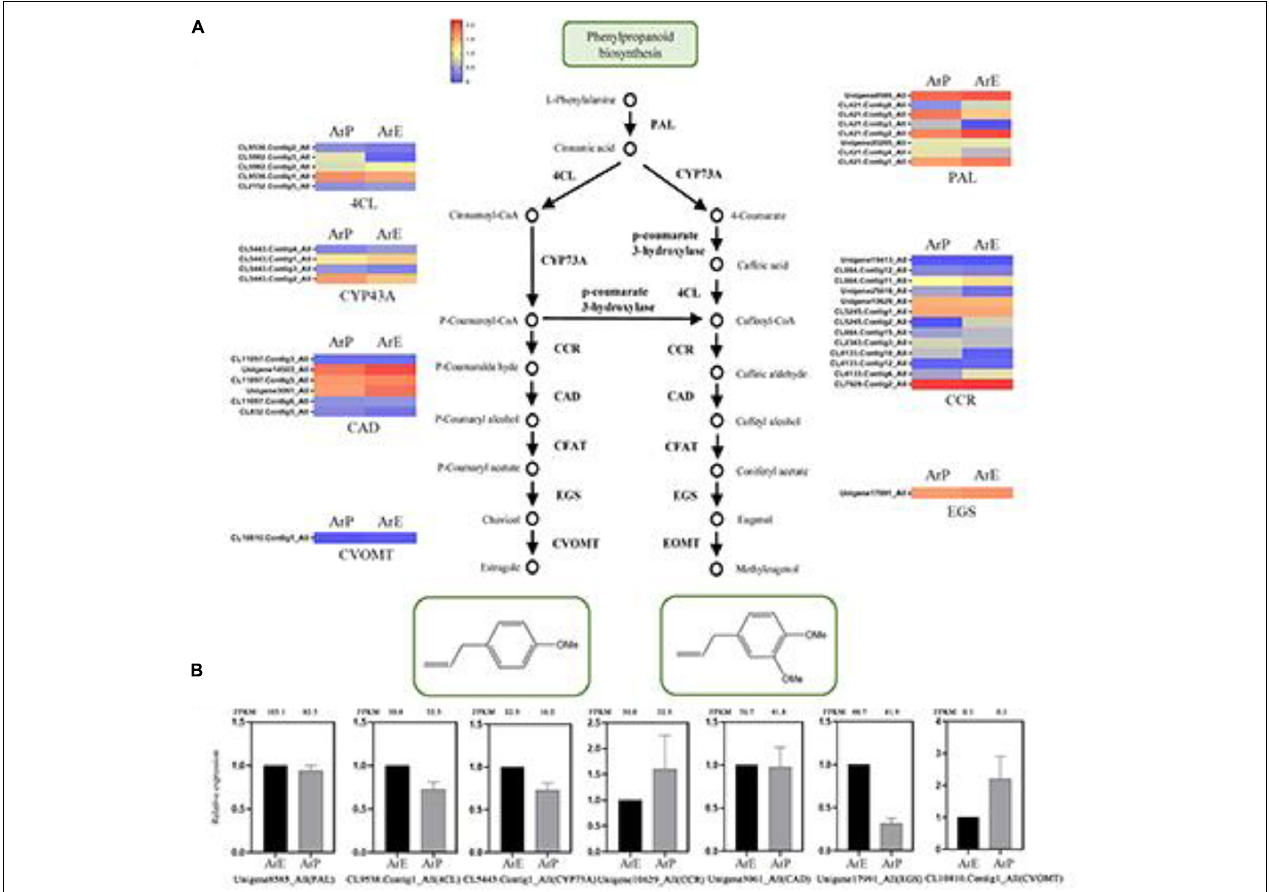
FIGURE 2 | Schematic overview of the phenylpropanoids biosynthesis pathway and the expression of representative genes by RT-qPCR. (A) Schematic overview of the phenylpropanoids pathway in A. rugosa and heatmap of the corresponding enzymes involved in the pathway. The main enzymes are shown with the abbreviation throughout respective enzymatic steps. Enzyme abbreviations are PAL, phenylalanine ammonia-lyase; 4CL, 4-coumarate: CoA ligase; CCR, coumaroyl-coA reductase; CAD, coumaryl-aldehyde dehydrogenase; CFAT, caffeic aldehyde acyltransferase; EGS, eugenol synthase; CVOMT, chavicol methyl transferase;